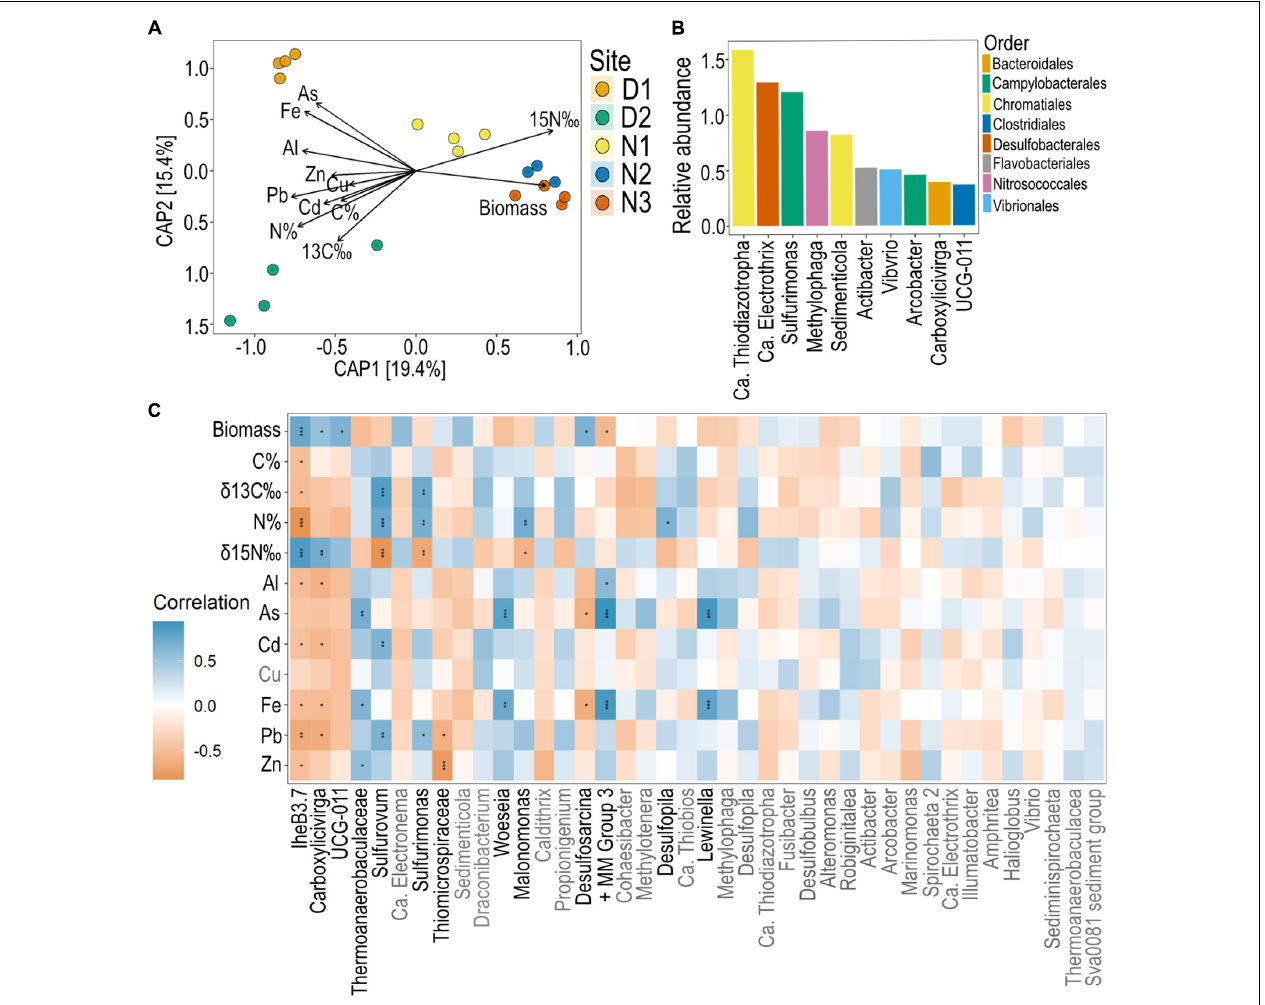
FIGURE 6 | Seagrass root bacteria across sites and their correlation with seagrass nutrient and metal concentrations. (A) CAP of Bray-Curtis dissimilatory measures of ASVs constrained by root properties (root biomass, root nutrients and root metal concentrations). (B) Top 10 most abundant ASVs across all sites of seagrass roots (agglomerated to genus). (C) Pearson’s correlation analysis between the top 40 most abundant ASVs (agglomerated to genus) and seagrass root parameters with significant Bonferroni corrected p -values indicated with a *, where * = 0.05, ** < 0.01, *** < 0.001. All metal concentrations are mg kg − 1 . + MM Group 3, Marine methylotrophic group